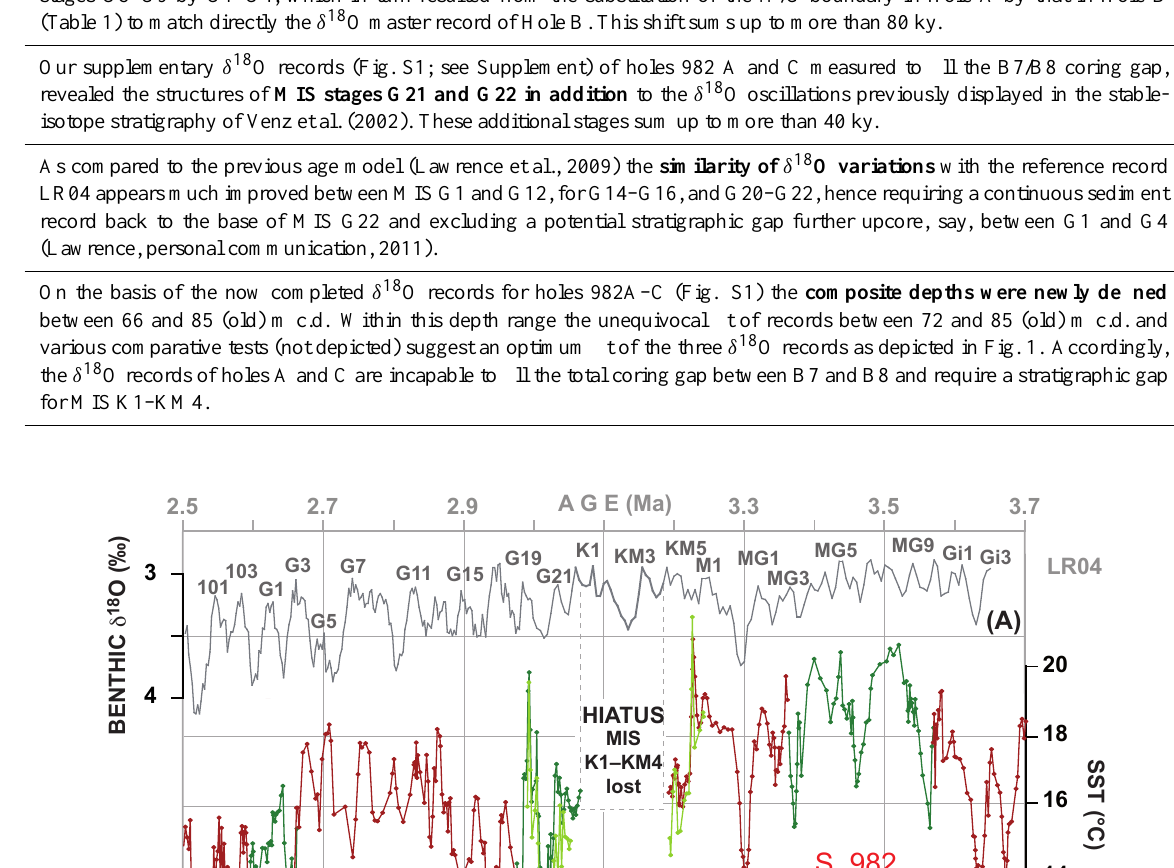
Table 2. Lines of evidence that justify the hiatus between MIS G22 and KM5. Consecutive rejuvenation of stable-isotope stratigraphy prior to MIS 104 as induced by the replacement of marine isotope stages G5–G9 by G1–G4, which in turn resulted from the substitution of the M/G boundary in Hole A by that in Hole B (Table 1) to match directly the δ 18 O master record of Hole B. This shift sums up to more than 80 ky. Our supplementary δ 18 O records (Fig. S1; see Supplement) of holes 982 A and C measured to fill the B7/B8 coring gap, revealed the structures of MIS stages G21 and G22 in addition to the δ 18 O oscillations previously displayed in the stable- isotope stratigraphy of Venz et al. (2002). These additional stages sum up to more than 40 ky. As compared to the previous age model (Lawrence et al., 2009) the similarity of δ 18 O variations with the reference record LR04 appears much improved between MIS G1 and G12, for G14–G16, and G20–G22, hence requiring a continuous sediment record back to the base of MIS G22 and excluding a potential stratigraphic gap further upcore, say, between G1 and G4 (Lawrence, personal communication, 2011).